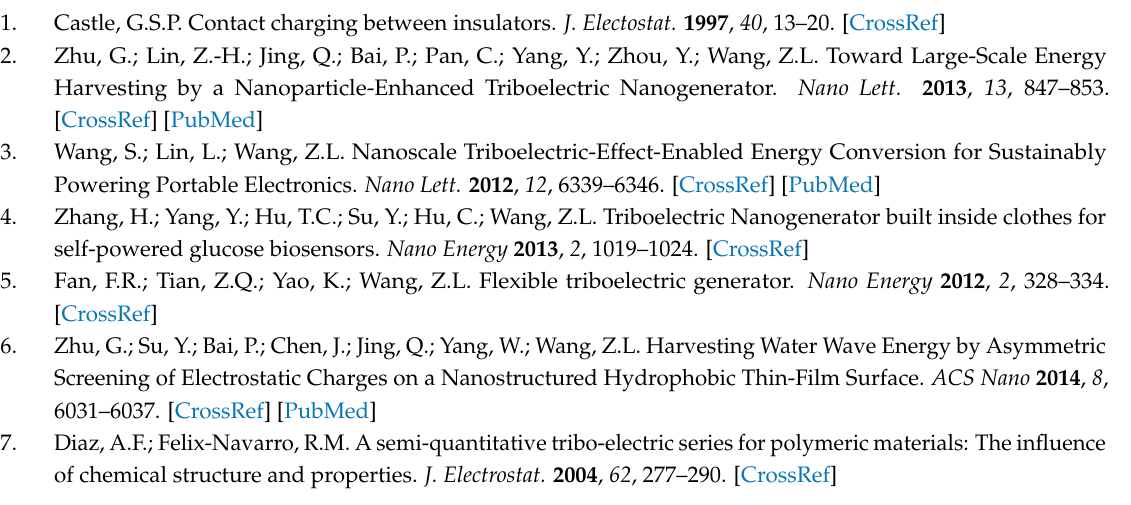
s1, Figure S1: The tilting direction of the OT-TES, Figure S2: The DAQ output voltage of the OT-TES when tilting the device in the straight direction, Figure S3: The DAQ output voltage of the OT-TES from eight Al electrodes when tilting the device in the diagonal direction, Figure S4: The DAQ output voltage of the OT-TES when tilting the device in the diagonal